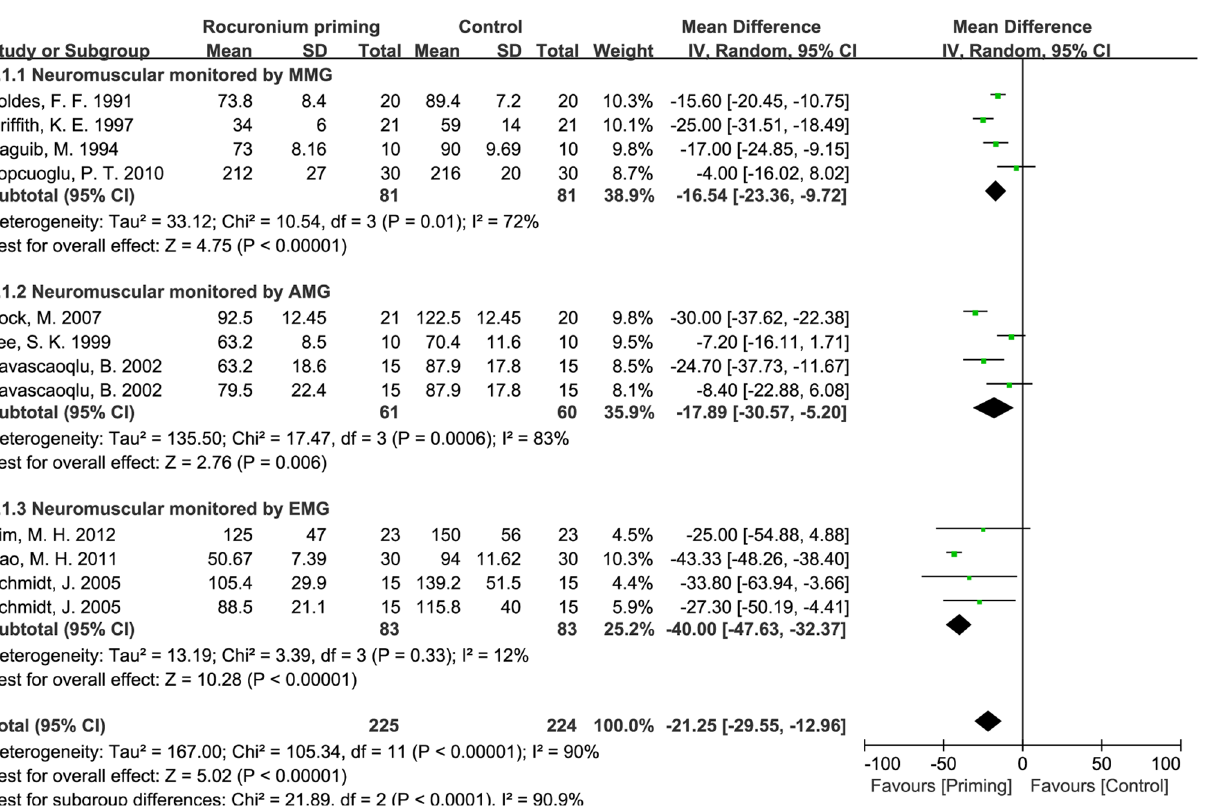
Figure 2. Effects of rocuronium priming on the onset time of rocuronium. Administration protocol of rocuronium priming: 0.06 mg/kg rocuronium was first intravenously administrated as priming dose, then 0.54 mg/kg rocuronium